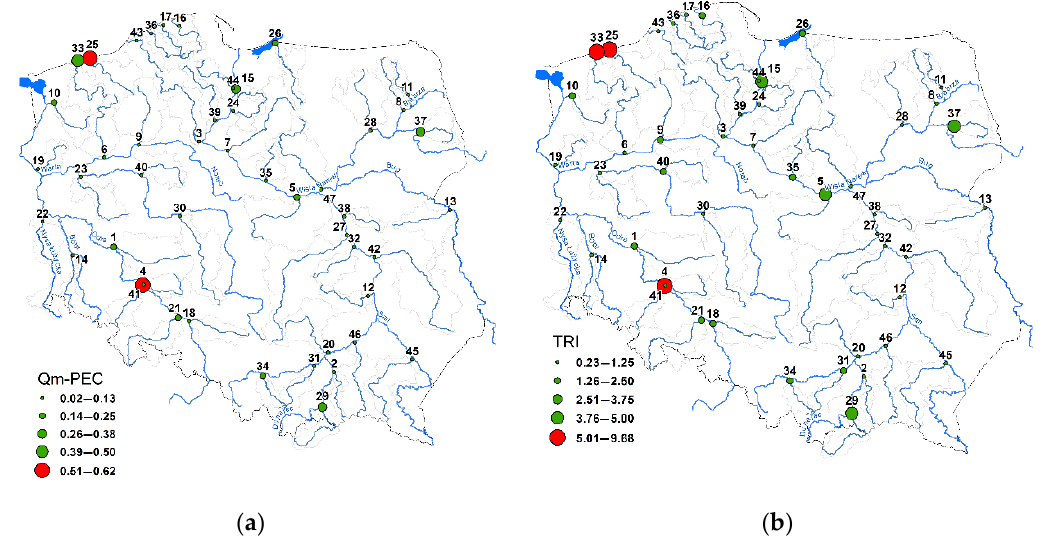
Figure 6. Potential toxic effects of HMs on aquatic organisms based on Qm-PEC ( a ) and TRI ( b ) indices. The numbers of sampling points are listed in the Appendix A.